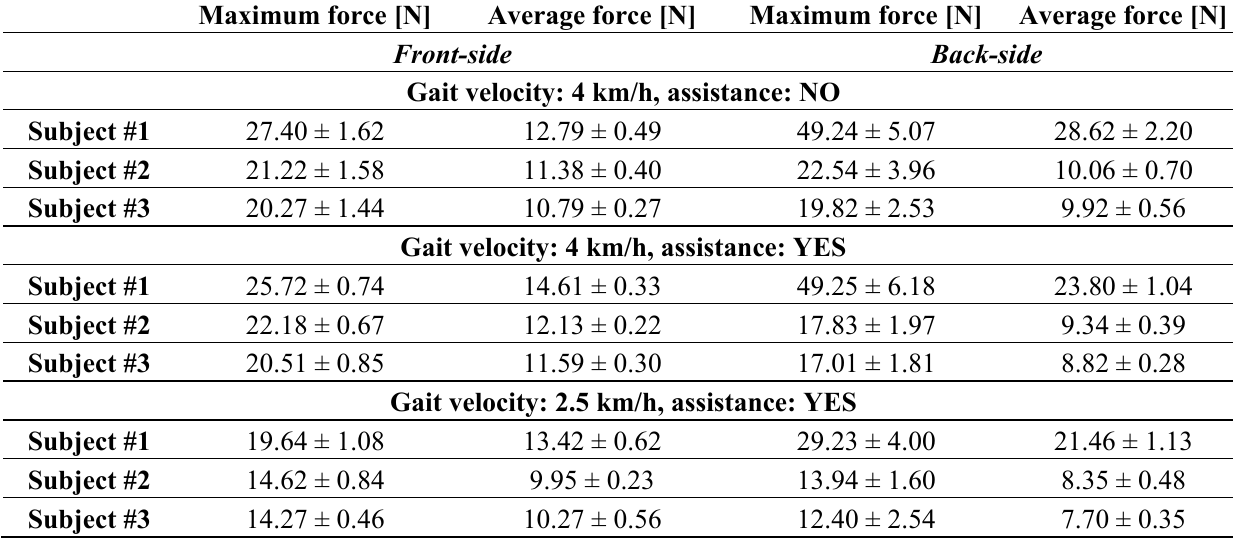
Table 3. Mean and standard deviation of maximum and average force recorded by right-leg thigh cuff front- and back-side PSPs 2.1 during a gait cycle. Data are reported for the three different gait conditions ( i.e. , gait velocity equal to 4 km/h, with and without assistive torque, and gait velocity equal to 2.5 km/h with assistive torque) and the three subjects. Maximum and average force values are averaged over 20 gait